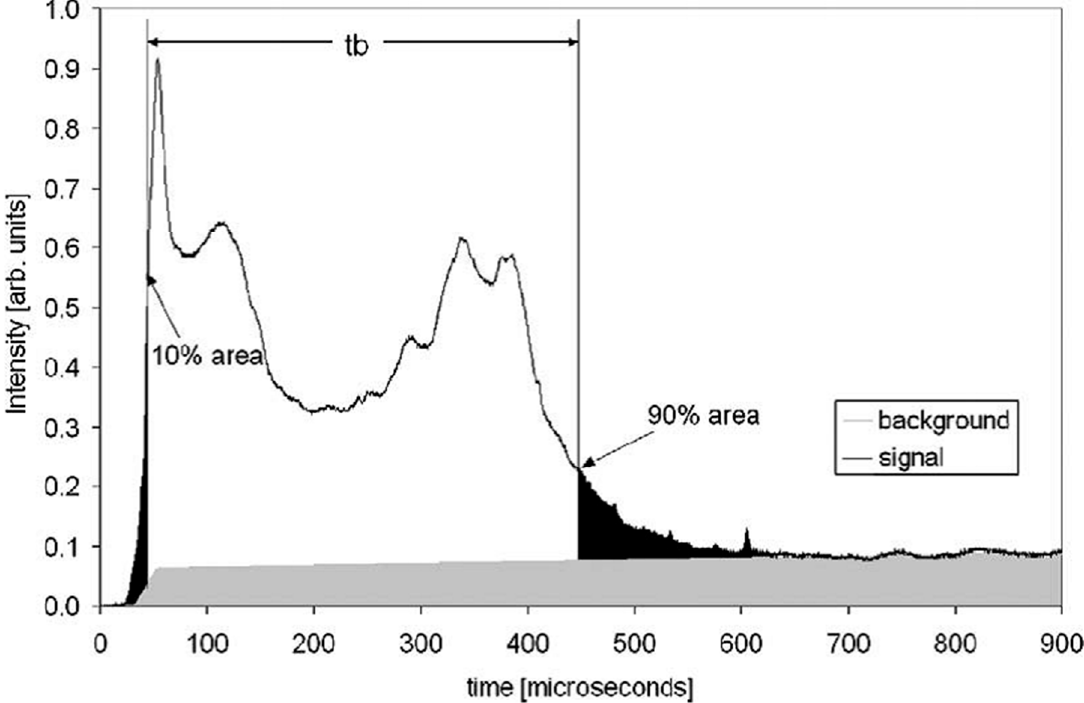
Figure 12. Visible light intensity vs. time traces for nanoaluminum in 50% CO 2 and 50% N 2 at 1760 K and 32.4 atm. Reproduced from [18], with permission from Elsevier, 2006.